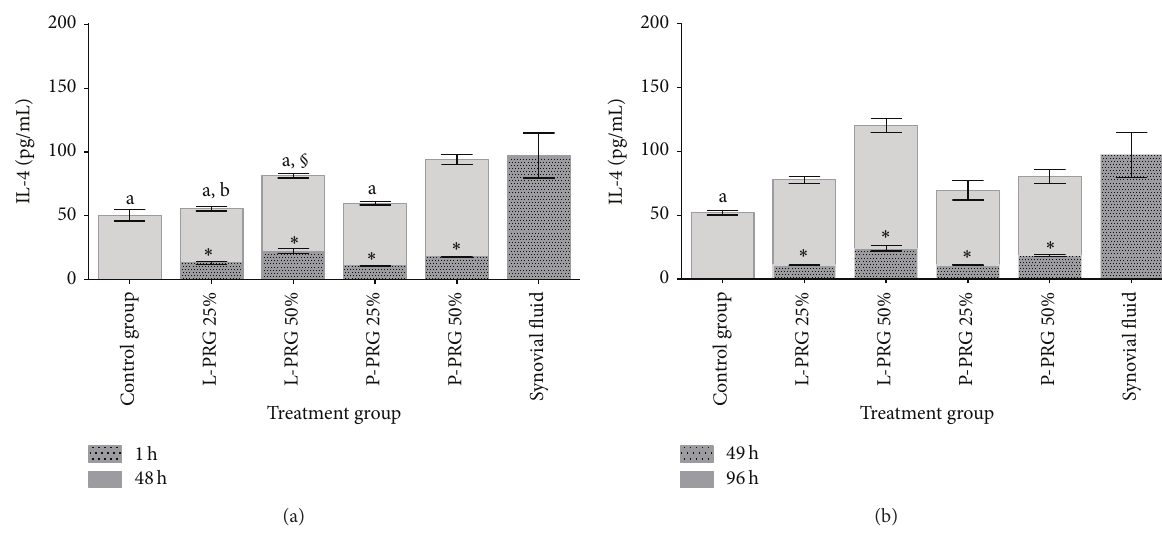
Figure 4: (a) a-b Lowercase letters denote significant ( 𝑃 < 0.05 ) differences between groups in the same column by Tukey test at 48 h. Significantly different with a: SF and b: P-PRG 50%. (b) a Lowercase letters denote significant ( 𝑃 < 0.05 ) differences between groups in the same column by Tukey test at 96 h. Significantly different with a: SF. ∗ Significant differences ( 𝑃 < 0.05 ) between the same variable at 1h and 48h and at 49 h and 96 by 𝑡 -paired test. § Significant differences ( 𝑃 < 0.05 ) between the same variable at 48 and 96 h by Tukey test.